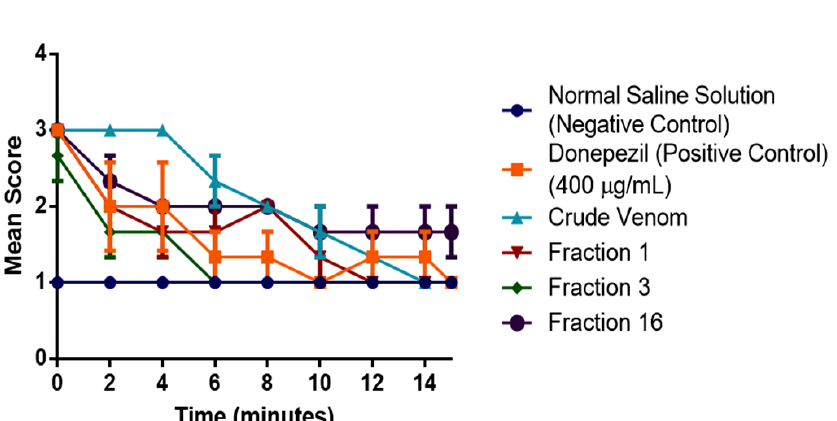
Figure 9. Behavioral trend observed in the locomotion of T. molitor after administration of Donepezil and spider venom in comparison with 0.9% NSS. Data are reported as mean ± SEM bars (n =